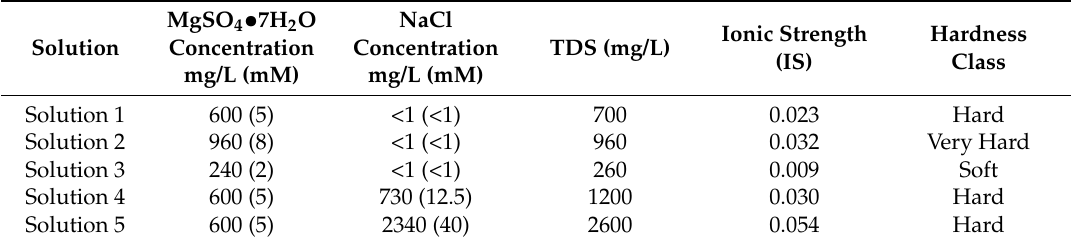
Table 2. Initial Feed Solution Information.